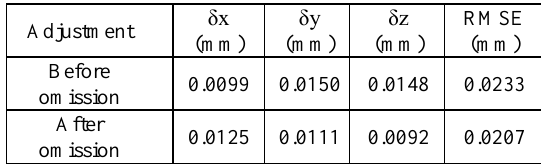
Table 5. The results of bundle adjustment of the car door before and after omission of images with low fuzzy values The result of Table 5 shows that the accuracy of bundle adjustment after omission of stations with low fuzzy values proves better, but a little. The reason of small proven in results was decreasing the stations and consequently decreasing the corresponding rays' intersection. In Figure 5, camera station error ellipsoids for car door before and after omission